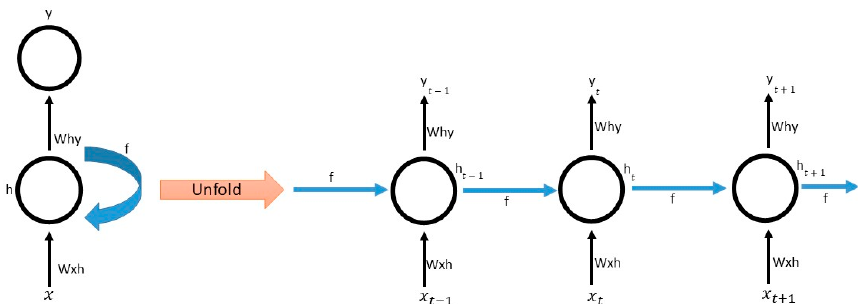
Figure 1. Architecture of RNN models. Note: Each state ( t ) has an input ( x ) and an output ( f ) from a previous state, which are processed in a hidden cell ( h ) to produce the final output ( y ).